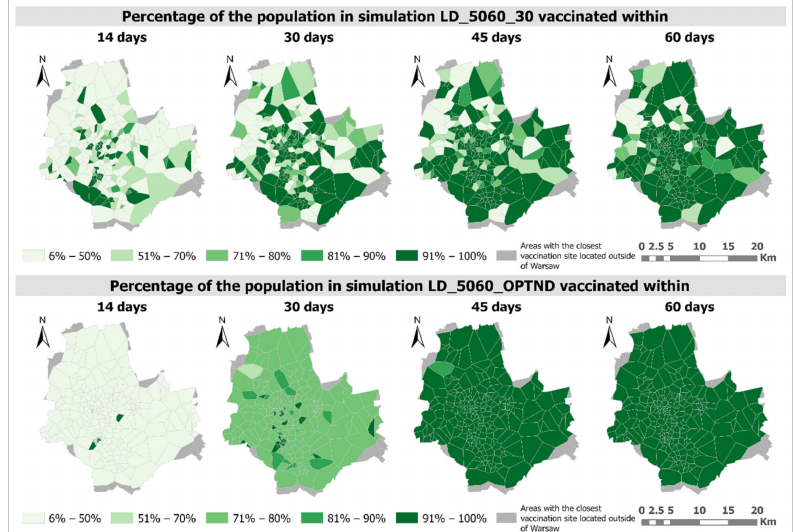
Figure 12. Percentage of the population of studied age groups that will be vaccinated within a specified number of days in LD_5060_30 and LD_5060_OPTND simulations.